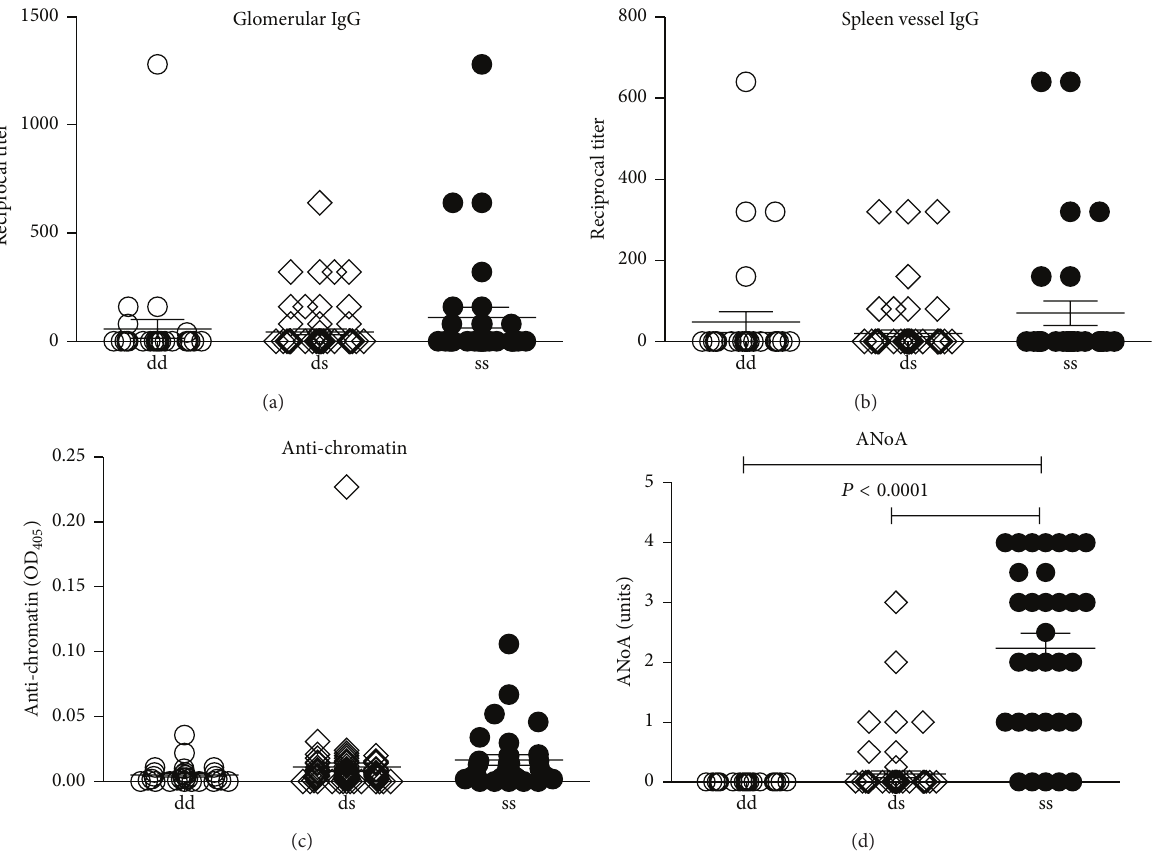
Figure 5: MHC class II is not associated with reduced immune deposits. MHC class II genotypes of (SJL/JxDBA/2)F2 intercross mice (H- 2 d , dd; H- 2 s , ss H- 2 ds , ds) were compared with features of mHgIA including glomerular deposits of IgG, splenic vessel deposits of IgG, antichromatin autoantibodies (ACA), and antinucleolar autoantibodies (ANoA). 𝑁 = 133